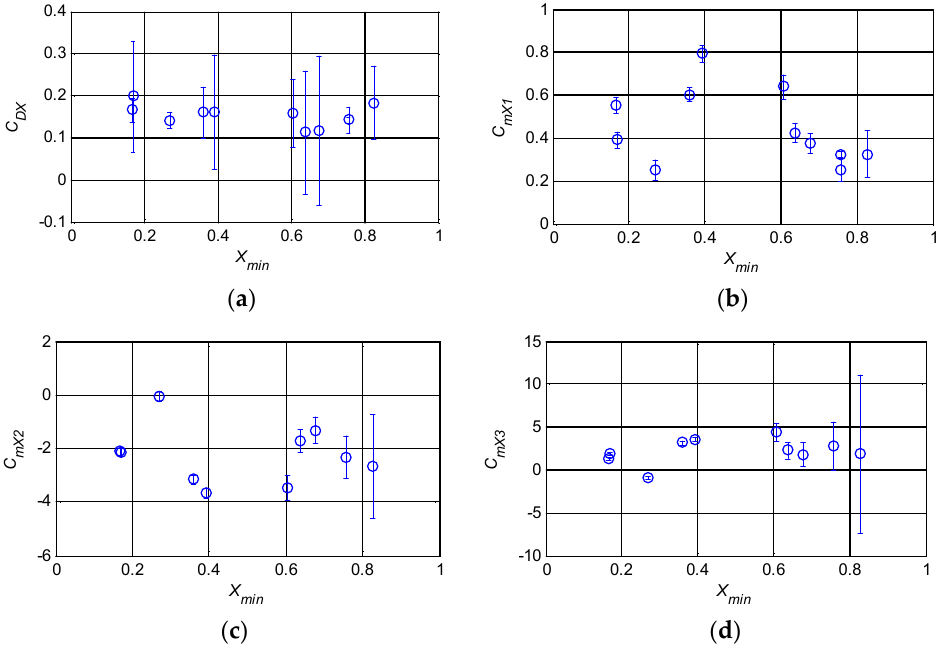
Figure 5. Lift coefficient fitting after optimization of stall aerodynamic parameters. ( a ) C L hysteresis curve for optimization of τ 1 and τ 2 ( α max = 21.8°); ( b ) C L hysteresis curve for optimization of τ 1 and τ 2 ( α max = 20.6°); ( c ) C L hysteresis curve for validation of τ 1 and τ 2 ( α max = 21.1°).